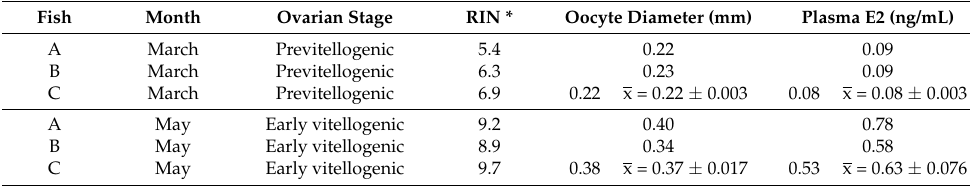
Table 1. Reproductive status (ovarian stage, mean oocyte diameter and plasma level of estradiol-17 β (E2) (mean ± SE) of the three F1 female h¯apuku ( Polyprion oxygeneios ) (fish A–C) repeatedly sampled in March 2013 and May 2013 to collect ovarian tissue (with respective RNA integrity numbers (RIN) of samples) for transcriptomic analysis.